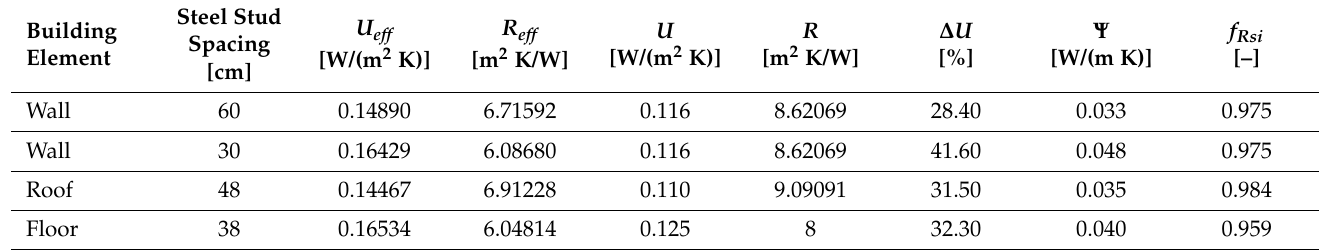
Figure 9. Model, temperature distribution, and heat flux. Table 5. Results of the numerical models for the effective thermal transmittance calculation.